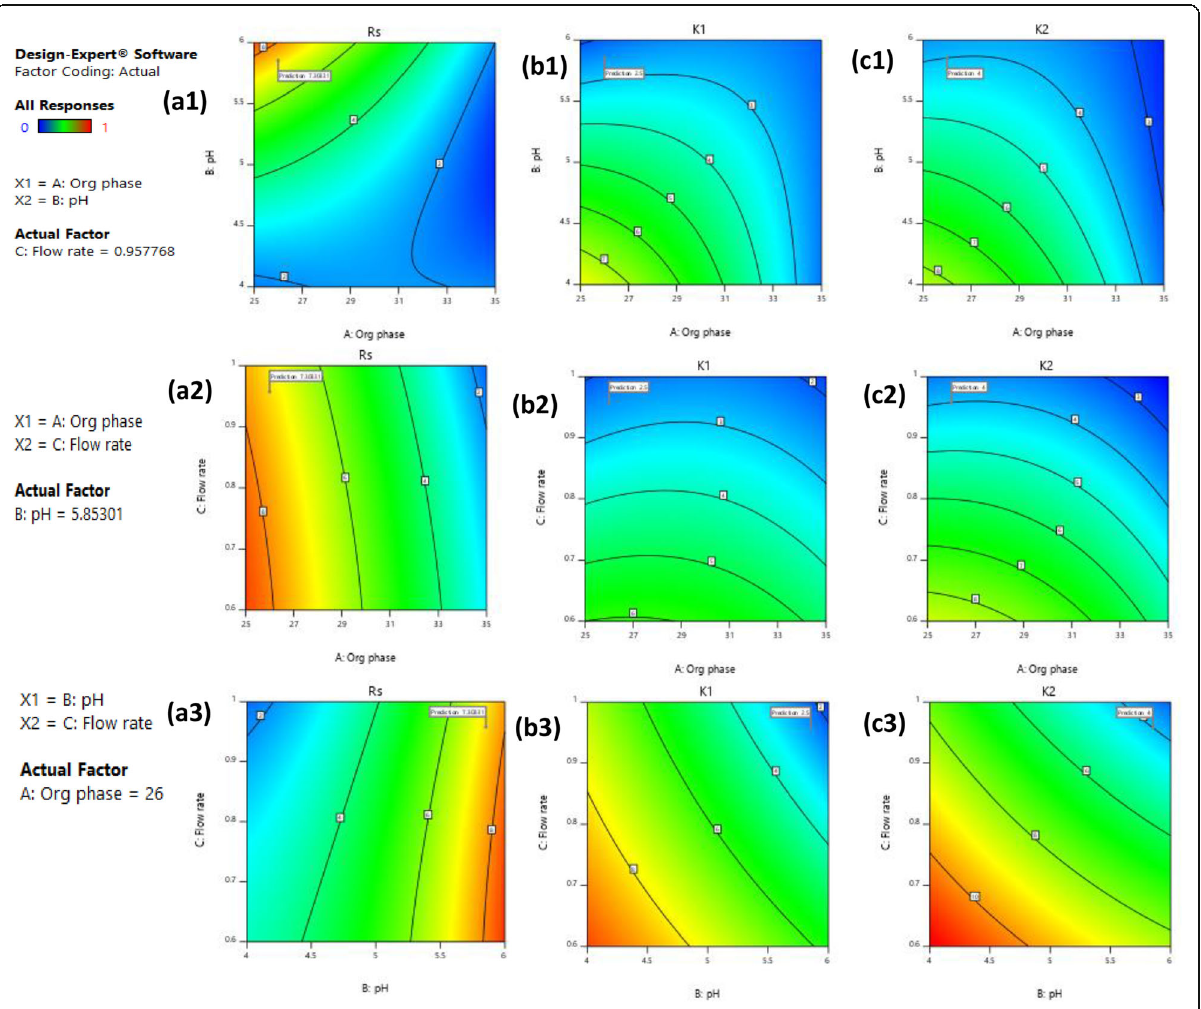
Fig. 5 HPLC separation of dapagliflozin and saxagliptin under stress conditions — acid ( a ), base ( b ), neutral ( c ), oxidative ( d ), UV light ( e ), and thermal ( f